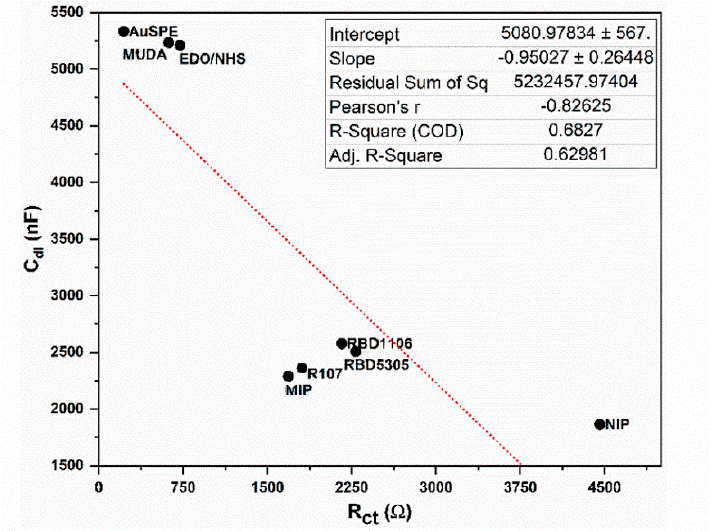
Figure 4. Plot of C dl versus R ct . The inset details the linear fitting herein used, being the r2 of − 0.8262. Data which showcased overlap: upper-left corner: MUDA and EDC/NHS; lower-central region: RBD 1106 and RBD 5305, as well as R 107 and MIP.